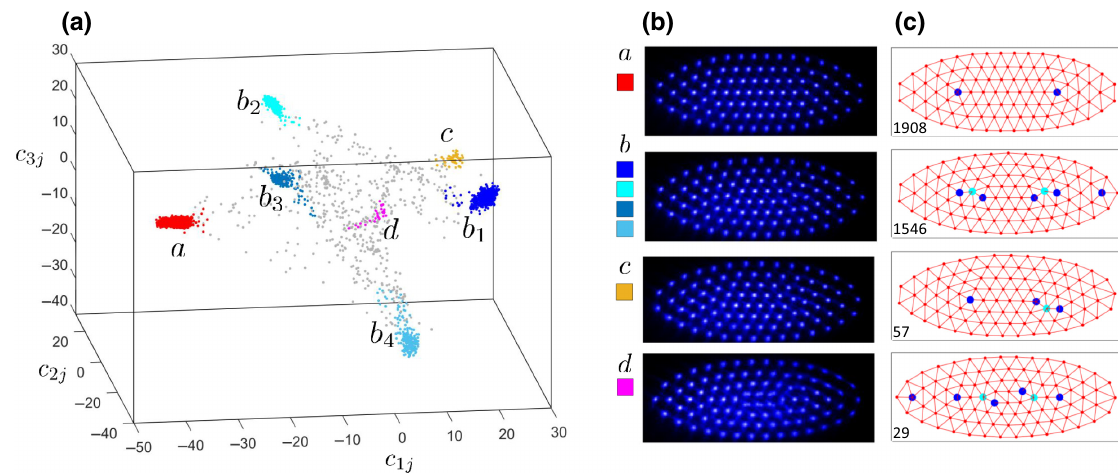
FIG. 5. Configuration analysis of a 91-ion crystal using 4100 camera images. (a) Each image is represented as a point in state space spanned by the projection coefficients c ij . Only the coordinates corresponding to the three highest eigenvalues are plotted. The clustering algorithm identifies seven different clusters ( a , b 1 – b 4 , c , and d ). Points are colored depending on their cluster label. Gray points are unlabeled and correspond to images where the ions are hot or undergoing a configuration change during the image